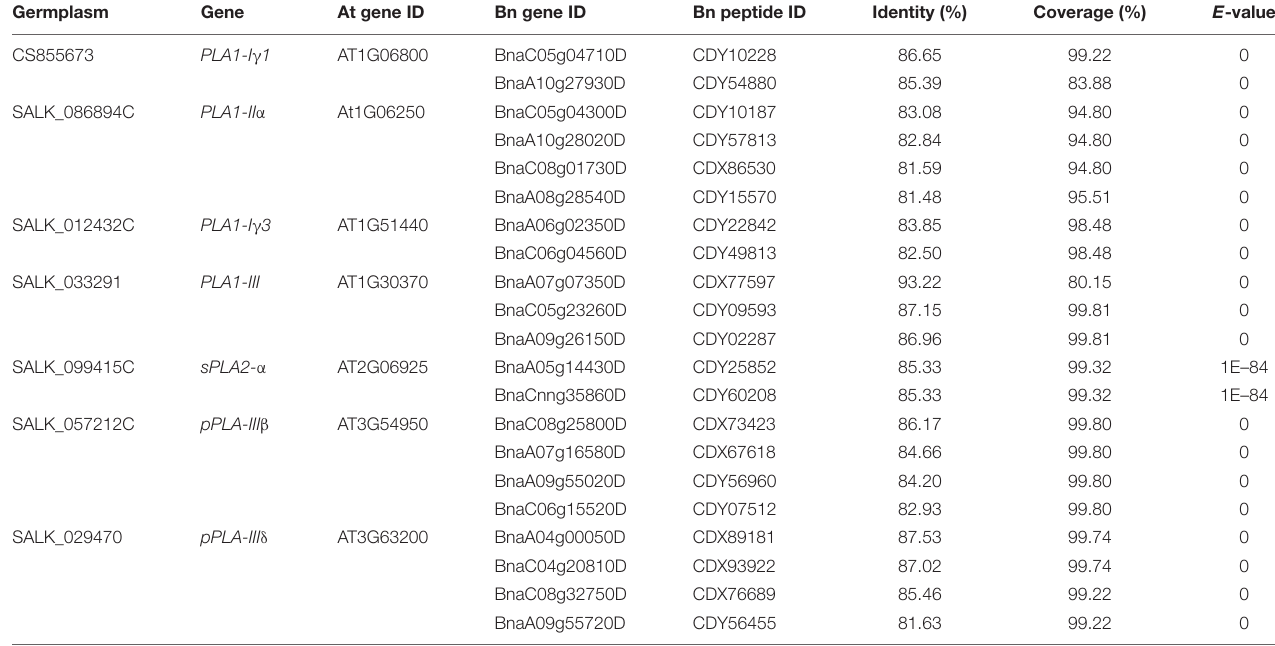
TABLE 1 | Arabidopsis thaliana (At) PLAs included in this study and their homologs in Brassica napus (Bn). Germplasm Gene At gene ID Bn gene ID